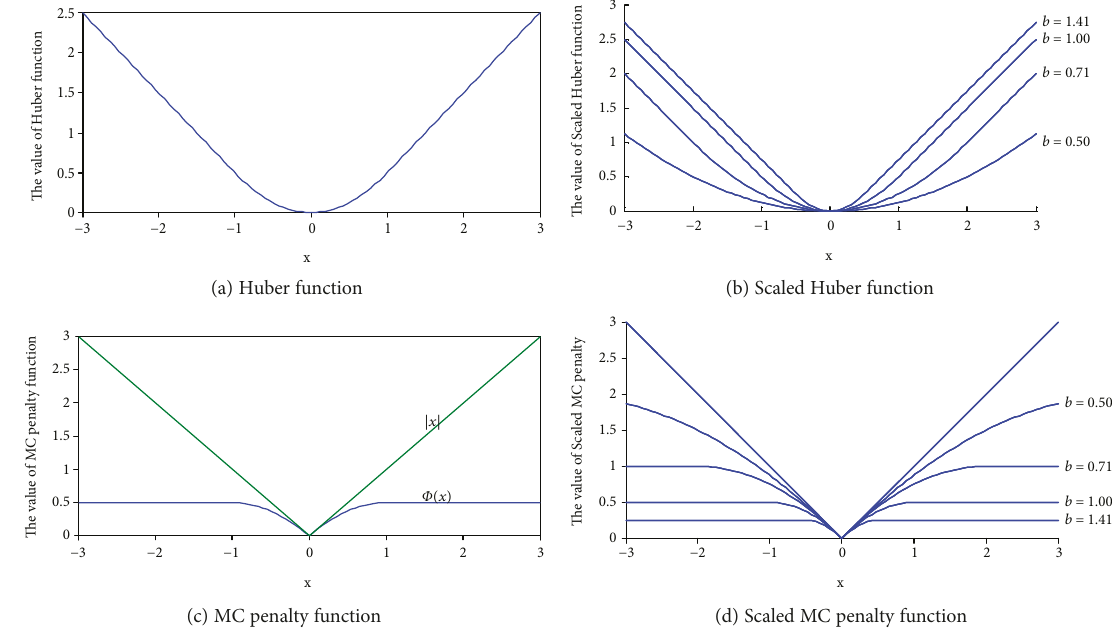
Figure 1: Di ff erent penalty